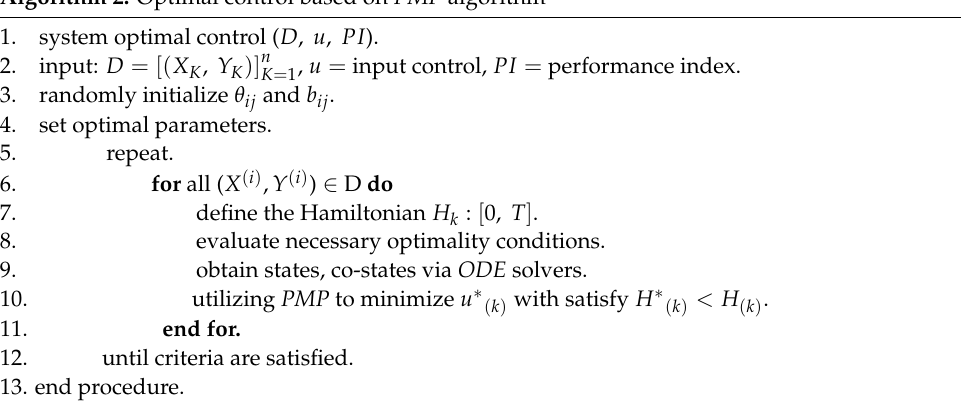
Algorithm 2: Optimal control based on PMP